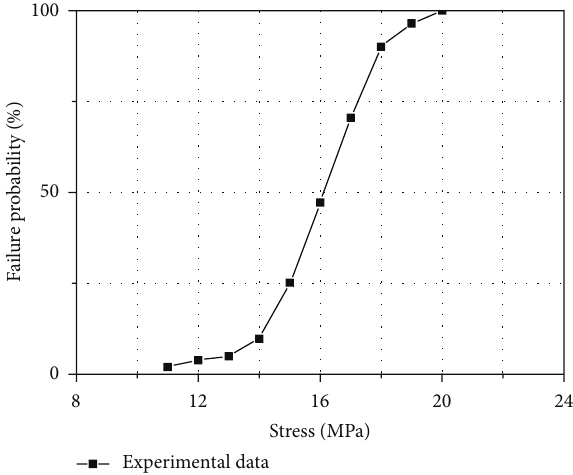
Figure 2: Tensile destruction curve of H-451 graphite.